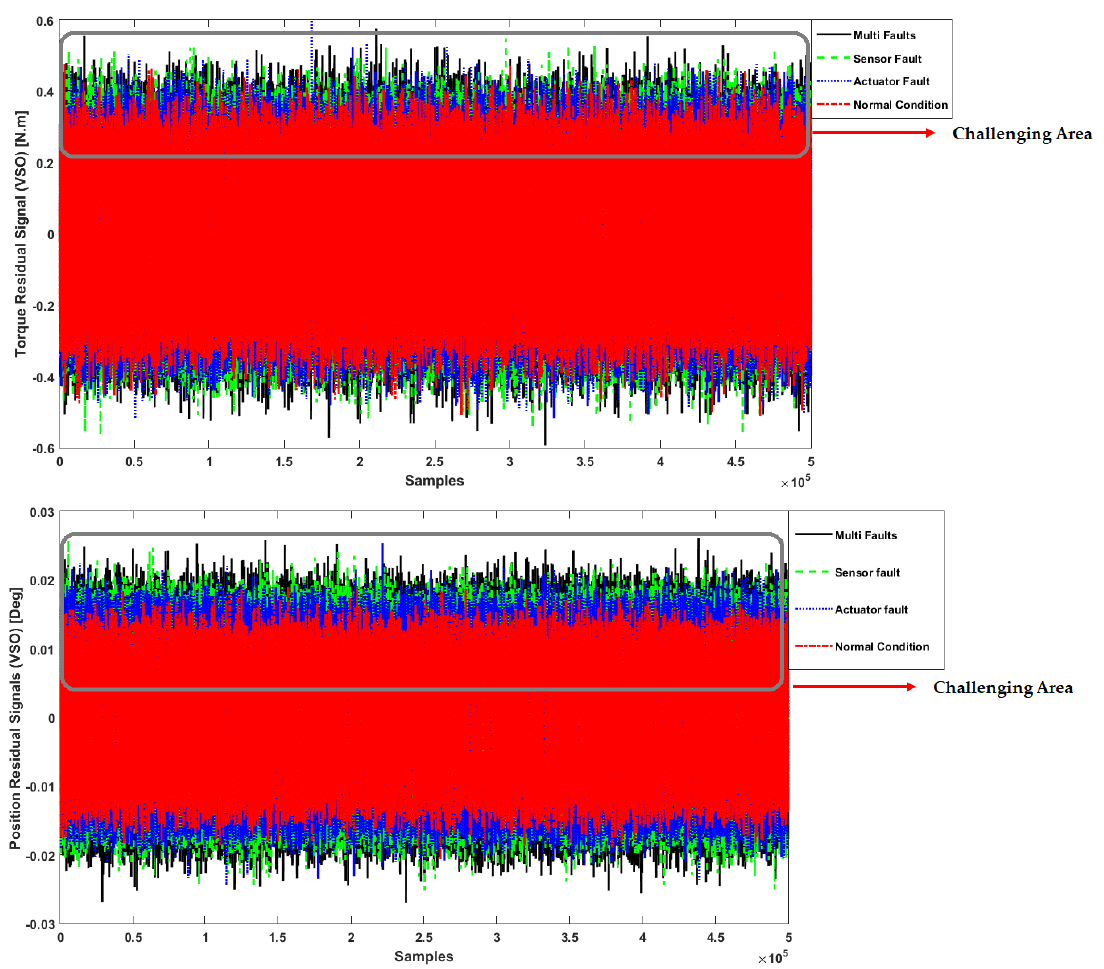
Figure 3. Torque and position residual signals of robot manipulator’s joints in normal and faulty conditions based on the variable structure observer (VSO) algorithm. Table 3. Fault diagnosis results for the robot manipulator based on ANHVSO, NHVSO and VSO.